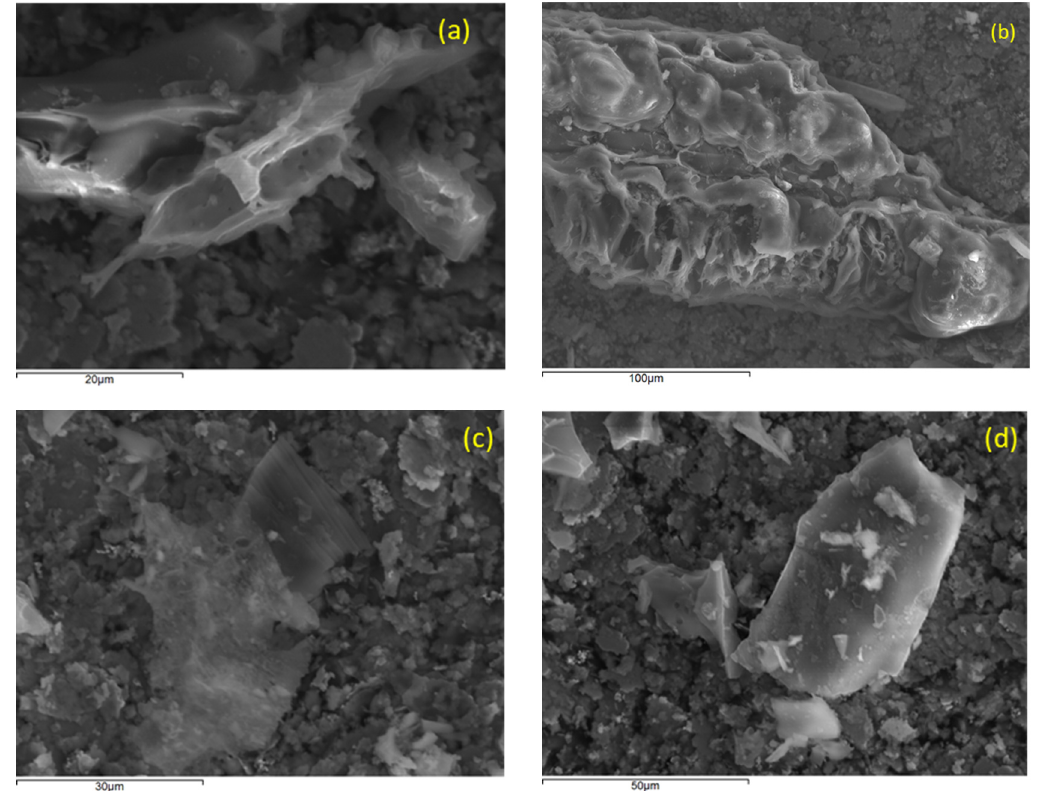
Figure 1. Scanning electron microscopy (SEM) images of the prepared biochars; ( a ) RHB400, ( b ) RHB550, ( c ) RHB700 and ( d ) RHB850.